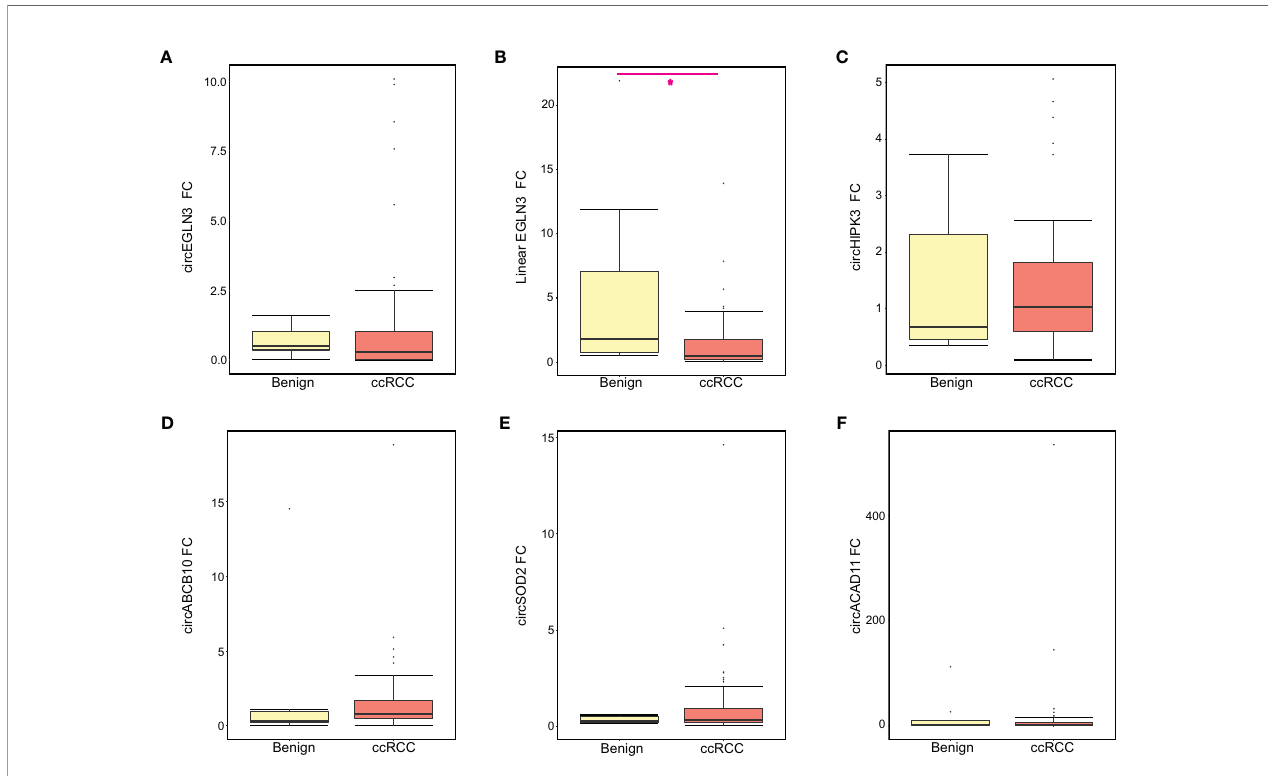
FIGURE 2 | Relative expression of all RNA candidates between benign and ccRCC groups. The relative fold-change (FC) for each RNA candidate was calculated for benign and ccRCC samples using normal samples as the control group. Boxplots show the median FC, fi rst and third quartile for (A) circEGLN3, (B) linear EGLN3, (C) circHIPK3, (D) circABCB10, (E) circSOD2, and (F) circACAD11. Mann-Whitney test results are shown (*p <